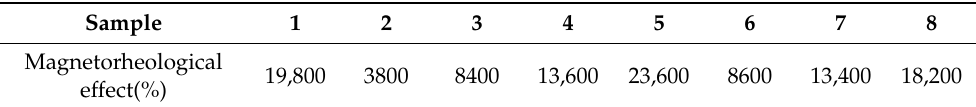
Table 3. Magnetorheological effect of eight